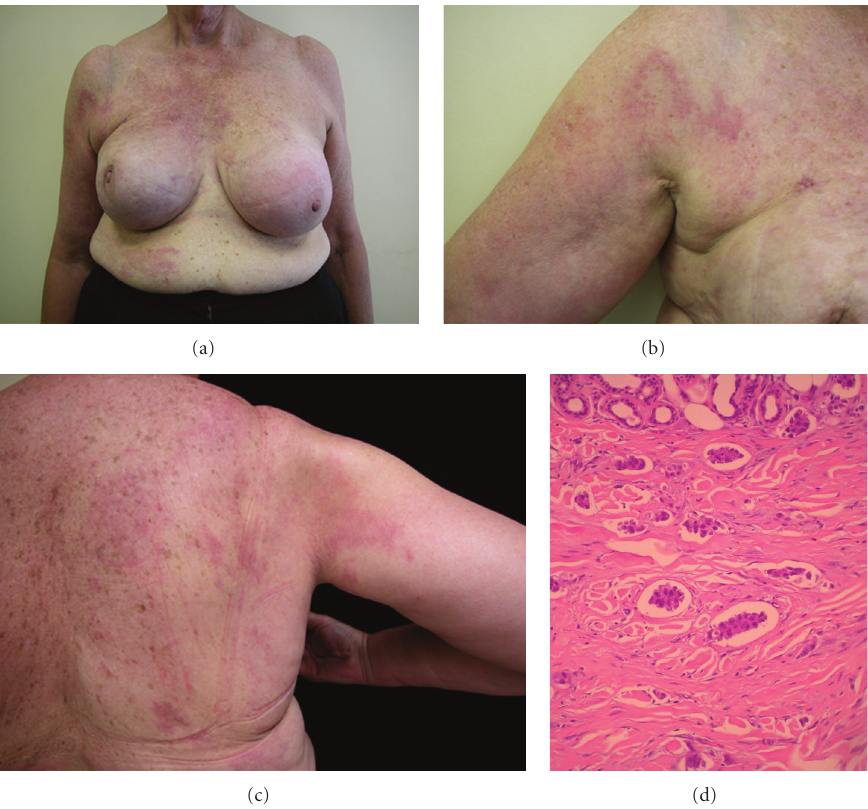
Figure 1: (a) The right breast is raised higher than the left breast and demonstrates nipple inversion. (b) Indurated erythema spreads across the right upper breast and upper arm. (c) Indurated erythema across the right upper back. (d) Extensive lymphatic invasion by infiltrative cords of epithelial